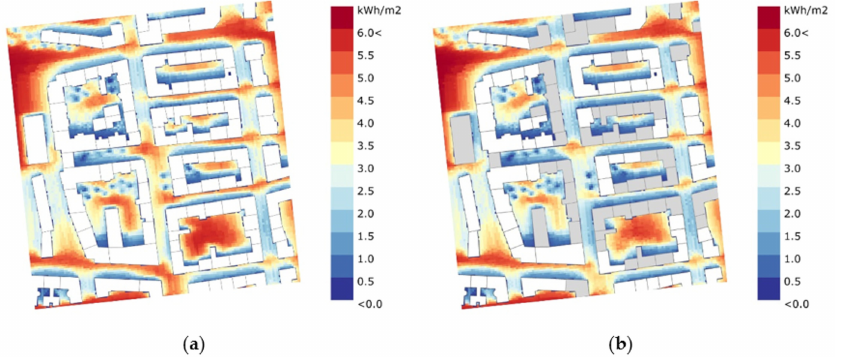
Figure 5. Total radiation reaching the ground surface: ( a ) base case; ( b ) densification (marked by grey